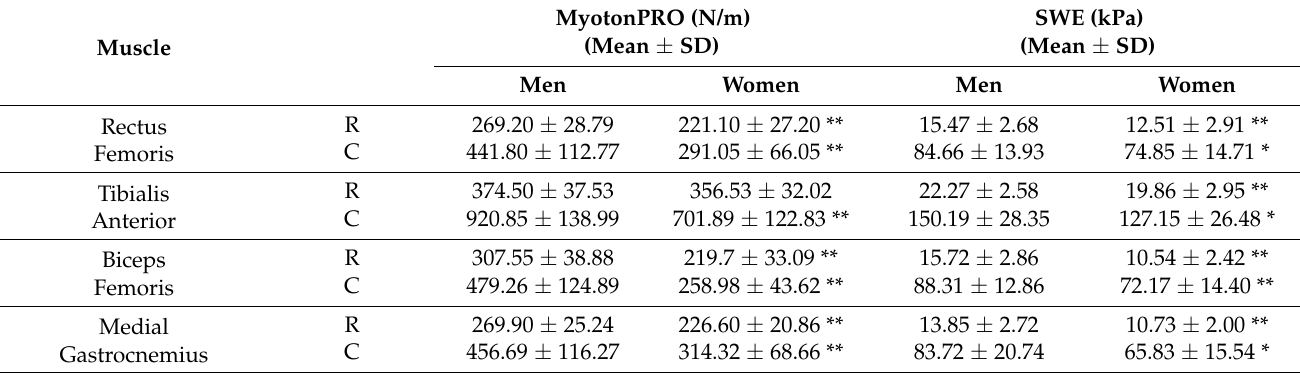
Table 3. Differences in muscle stiffness between men and women ( N = 40).